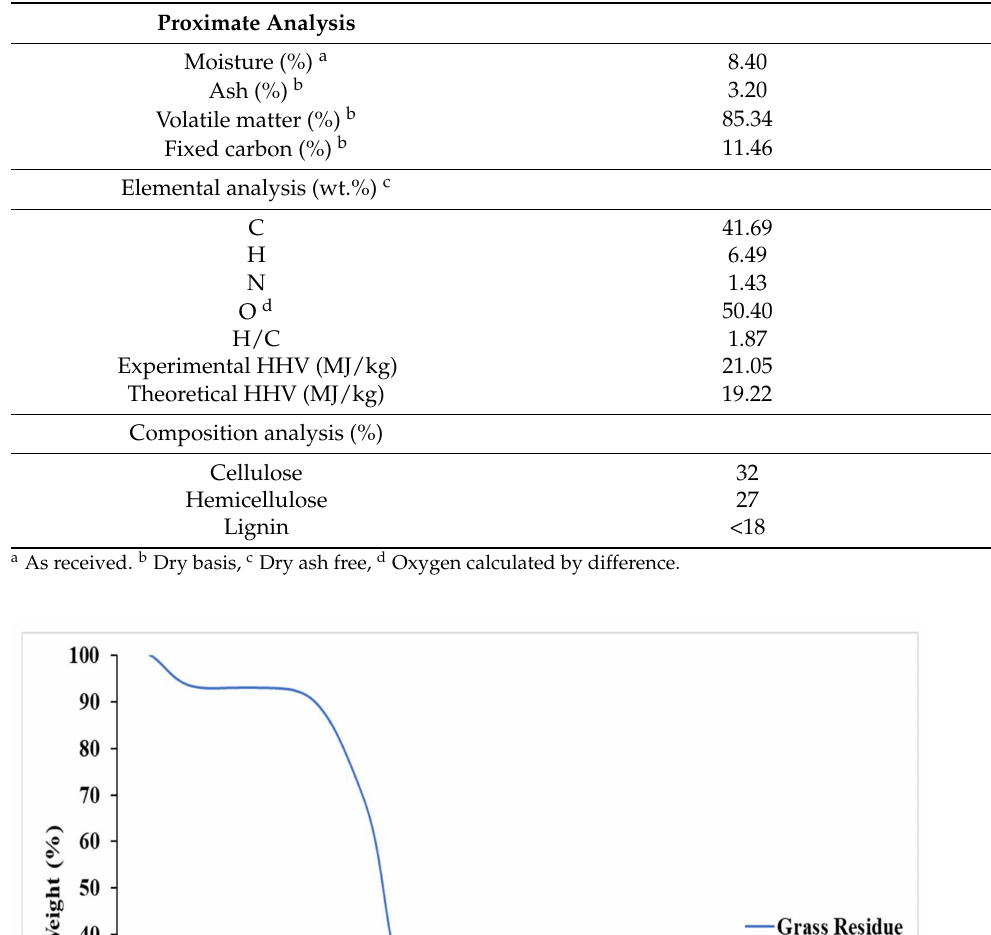
Table 1. Characterization of grass residue used in the HTL experiments.